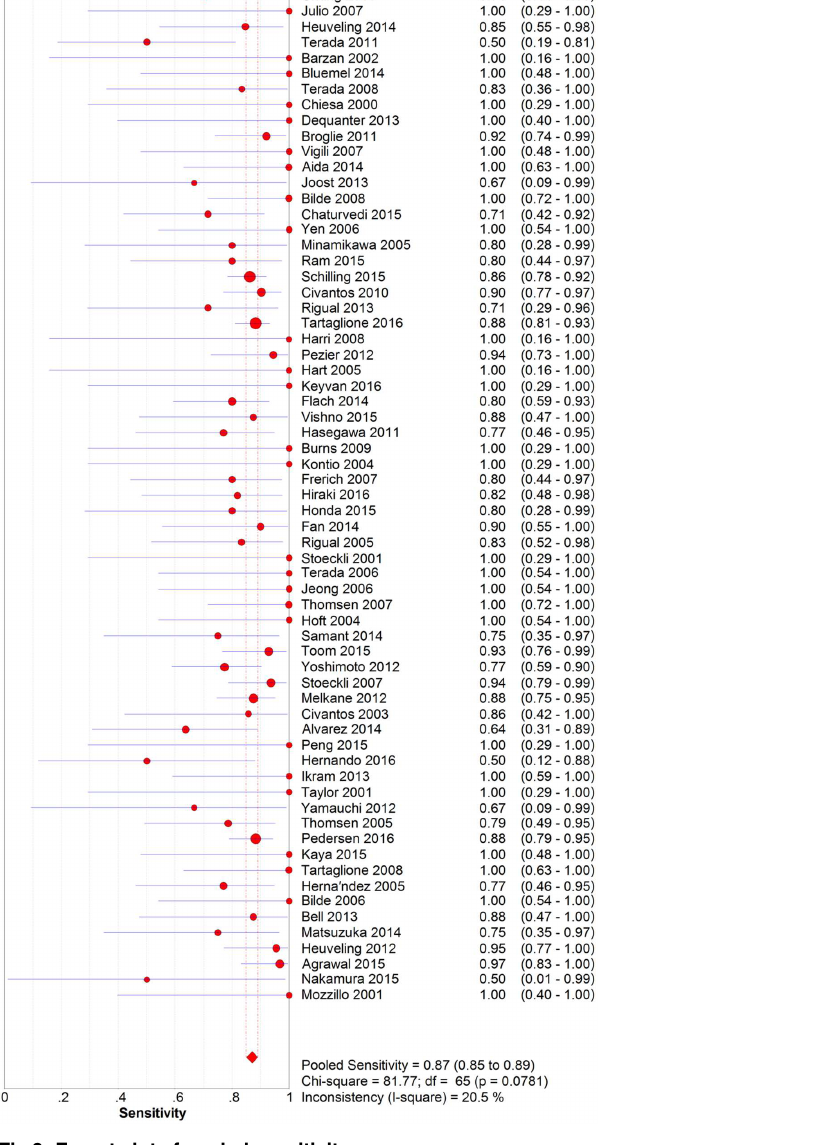
Fig 3. Forest plot of pooled